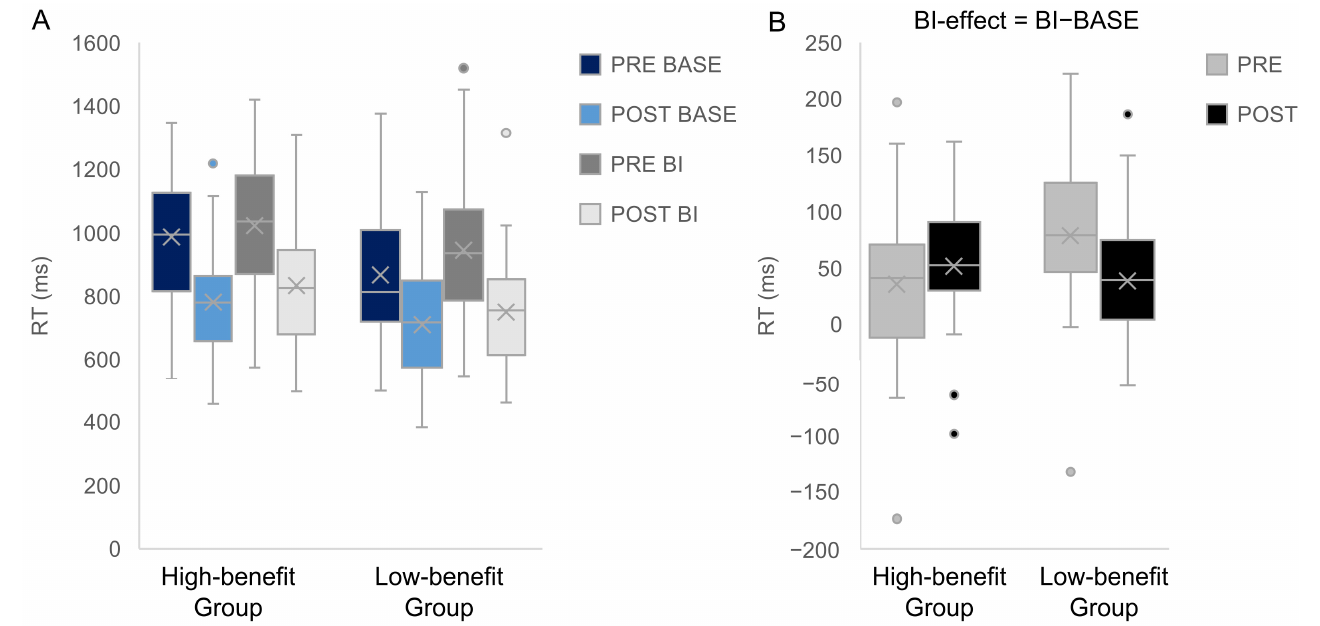
Figure 7. Reaction time data for the BI and the BASE condition in the high-benefit group and low- benefit group are presented ( A ). The BI-effect (i.e., BI condition/BASE condition) for the two groups is shown ( B ). The groups were defined by a median split (median = 4) regarding the differences between the pre- and post-appointment CY-BOCS scores. Within each box, horizontal grey lines denote median values; boxes extend from the 25th to the 75th percentile of each group’s distribution of values; whiskers above and below the box indicate the 10th and 90th percentiles (i.e., the most extreme values within 1.5 interquartile range of the 25th and 75th percentile of each group); dots denote observations outside the range of adjacent values.